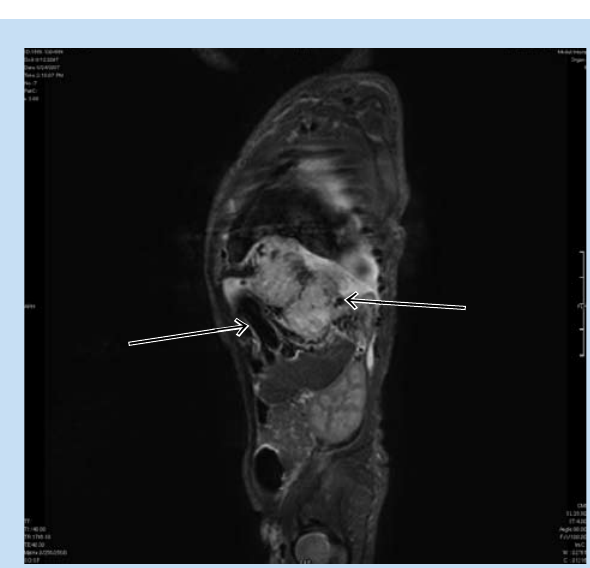
Fig. 2b. Hyperintense mass on sagittal T2 fat suppression sequence. Prominent vascular flow voids seen (arrows). The diaphragm is poorly